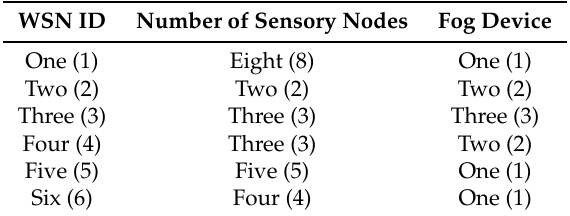
Figure 4. The experimental prototype system setup, programmed and installed in different locations of the Ionian University’s facilities in Corfu Town. Table 1. Deployment setup of the WSNs and fog